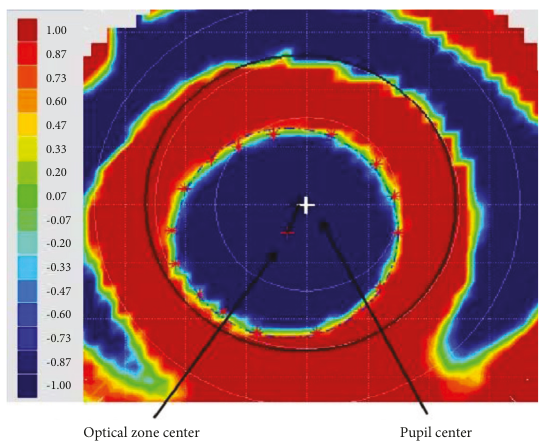
Figure 2: Optical zone decentration distance measurement (decentration distance was measured from the center of the optical zone to the pupil